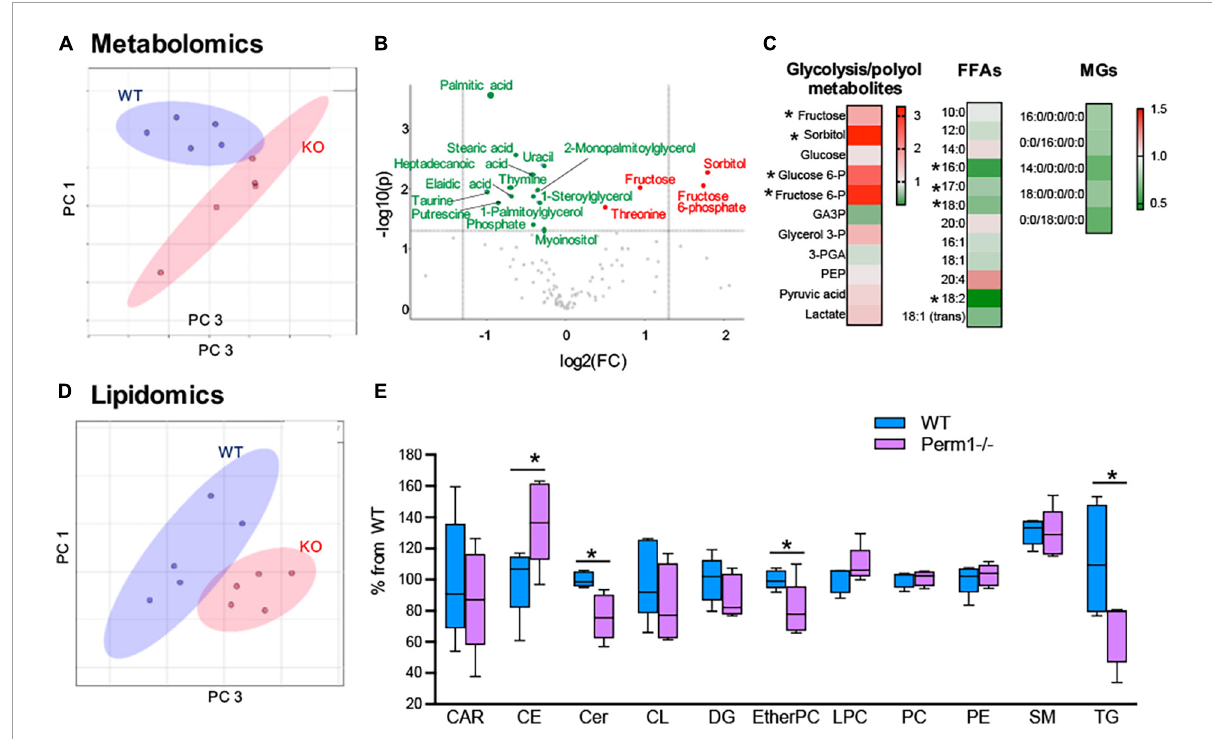
FIGURE4 Metabolomic and lipidomic analyses of left ventricle tissue from Perm1 − / − mice and WT mice ( n = 6/group in metabolomics and n = 5/group in lipidomics). (A–C) Metabolomic profile of Perm1 − / − hearts. (A) PCA of all detected metabolites in Perm1 -null hearts (red) and WT hearts (blue). (B) Volcano plot contains the significantly increased (red) and decreased (green) metabolites in Perm1 − / − hearts compared with those in WT hearts ( p < 0.05). X -axis indicates fold change (FC) in log2 scale and y -axis indicates p -value in -log10 scale. (C) Heat maps of metabolites in glycolysis and polyol pathways, and free fatty acids (FFAs) and monoglycerides (MGs). (D,E) Lipidomic profile of Perm1 − / − hearts. PCA of all detected lipids in Perm1 − / − (red) and WT hearts (blue) (D) , and box and violin plot of the total lipid species in each lipid group (E) . * p <